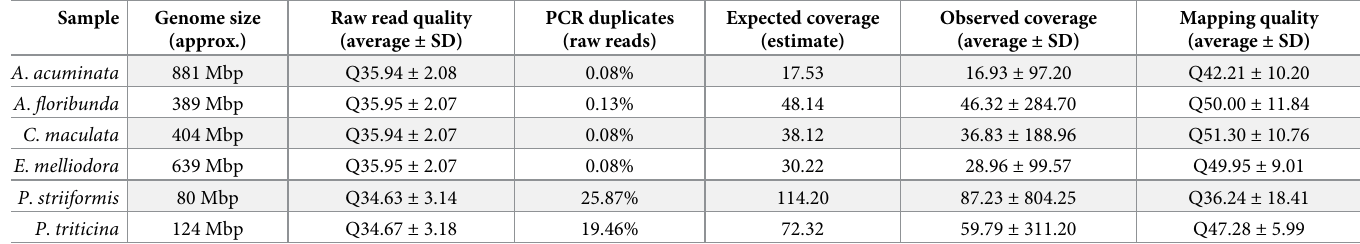
Table 2. Summary statistics of six libraries generated with the presented cost-conscious protocol and sequenced on the Illumina NovaSeq 6000 platform. Libraries consist of four plants ( Acacia acuminata , Angohpora floribunda , Corymbia maculata , Eucalyptus melliodora ) and two fungi ( Puccinia striiformis f. sp. tritici , Puccinia triti- cina ). Quality scores are presented based on the Phred scale. PCR duplicates were calculated independent of a reference genome, with HTStream SuperDeduper [17]. Expected coverage was estimated by sequencing output divided by genome size. Observed coverage was calculated by mapping the reads against an independently gener- ated long-read de novo assembly. SD denotes standard deviation.